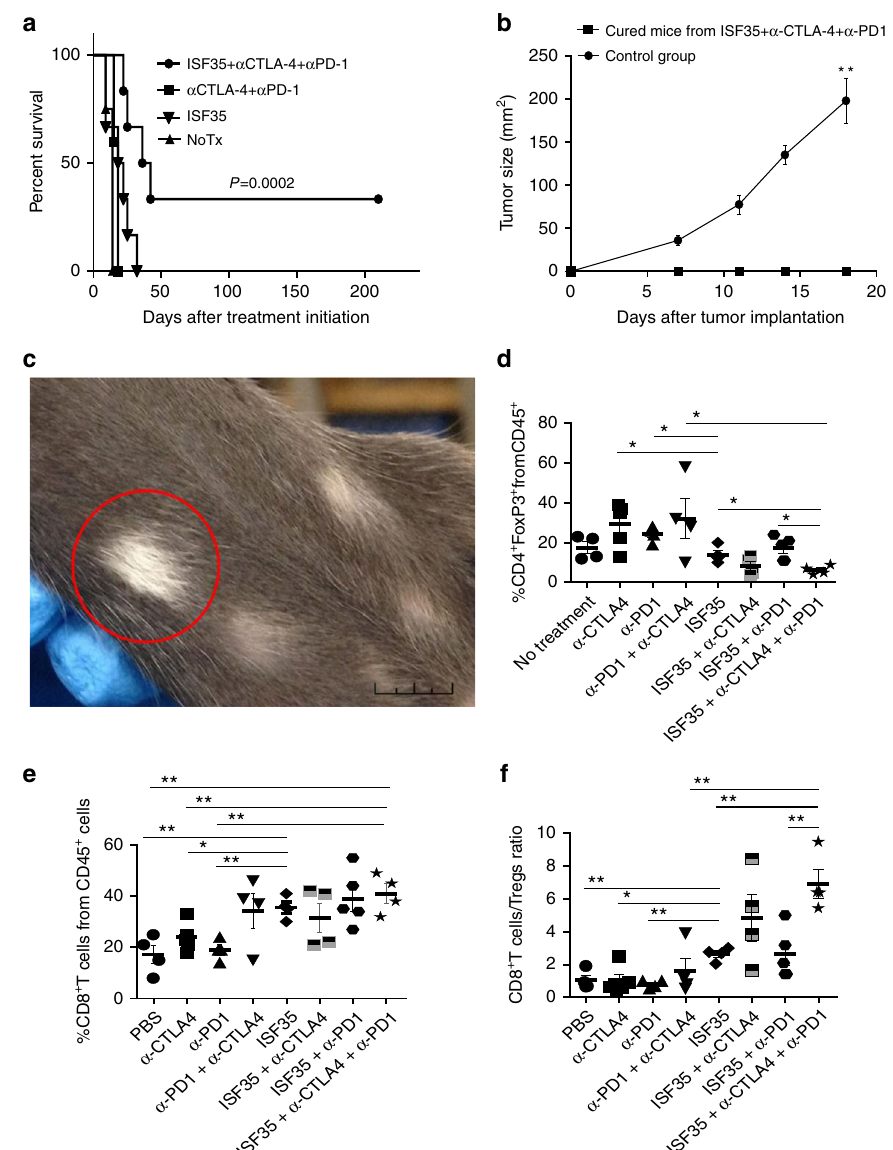
Fig. 5 Synergistic effect of intratumoral ISF35 with anti-CTLA-4 and anti-PD-1 antibody blockade. Mice bearing 8-day s.c. B16.F10 tumors were treated as indicated. a Mouse survival. b Tumor growth after rechallenge of cured mice. c Vitiligo in a cured mouse (1 cm; represents 3 mice). Mice bearing 8-day s.c. B16.F10 tumors were treated as indicated, and 9 days later, tumors were analyzed for the presence of d Tregs (CD4 + FoxP3 + ) ( e ) CD8 + T cells and f CD8 to Treg ratio. Data are analyzed by unpaired two-tailed t test. * P < 0.05, ** P < 0.005 ( n = 4 – 8 mice). Error bars are